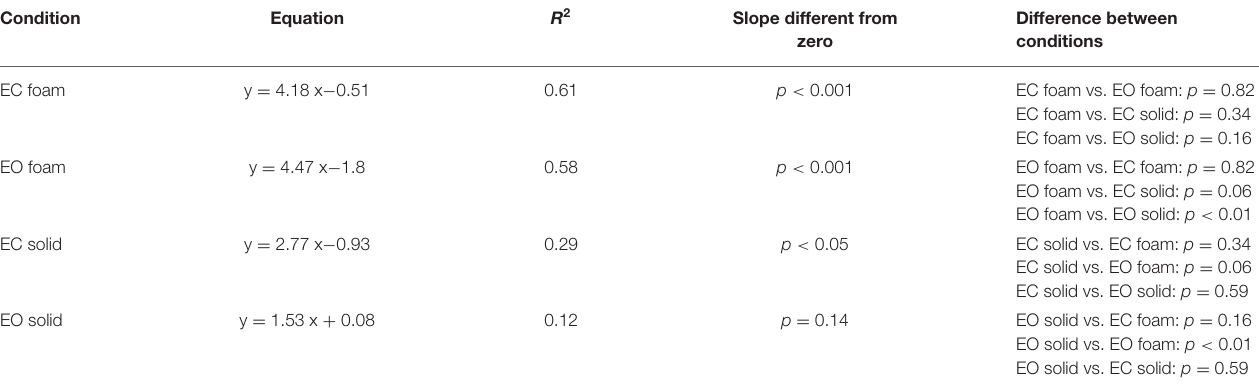
TABLE 1 | Relationship between Sway Area and Path Length.